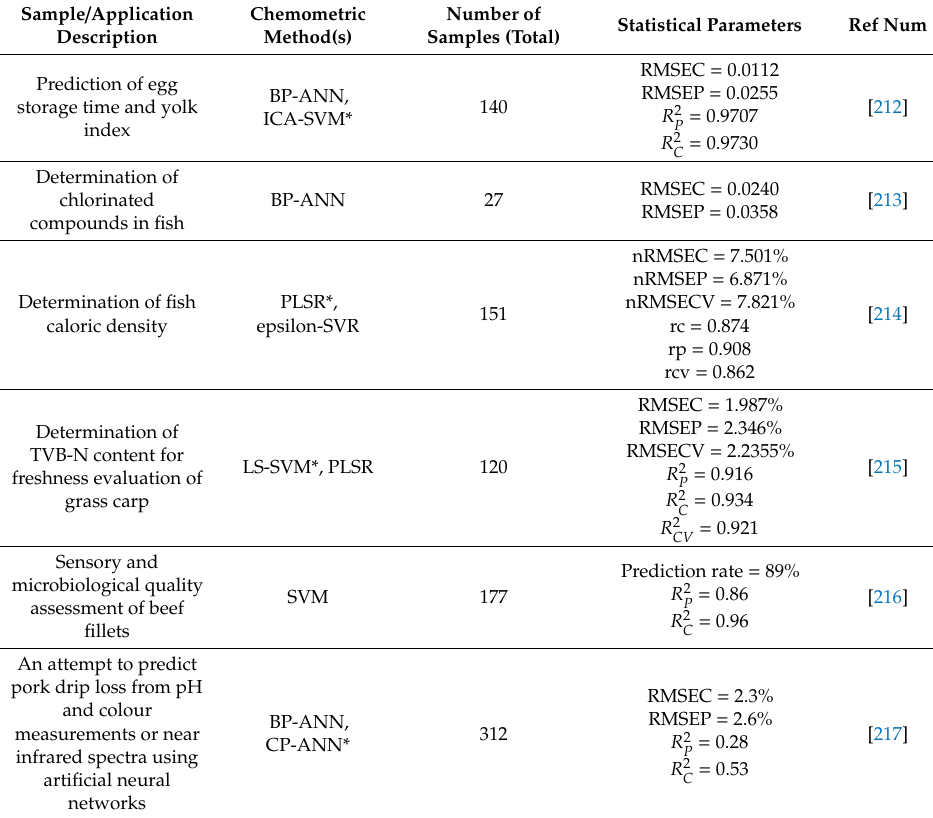
Table 11. Literature related to the use of chemometrics in prediction of properties of